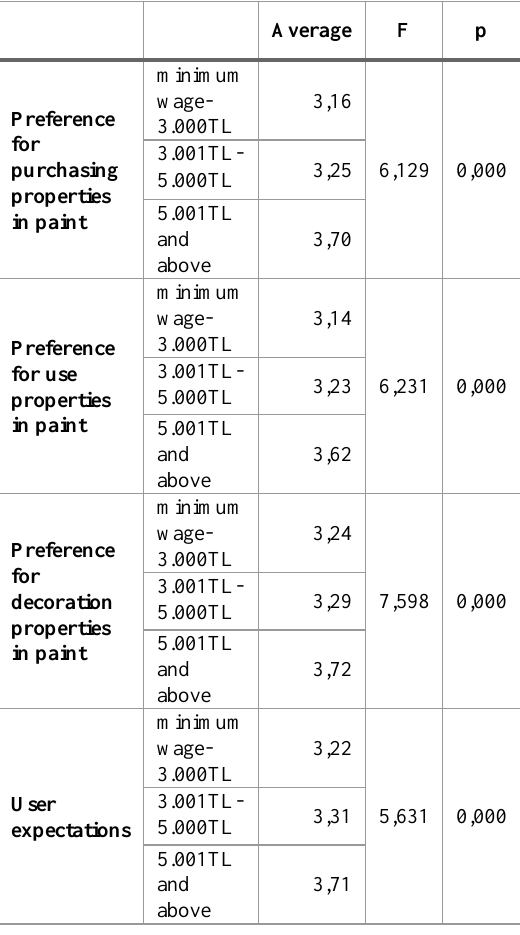
Table 19: ANOVA Test on Consumers' Preferences for Paint by Income Level